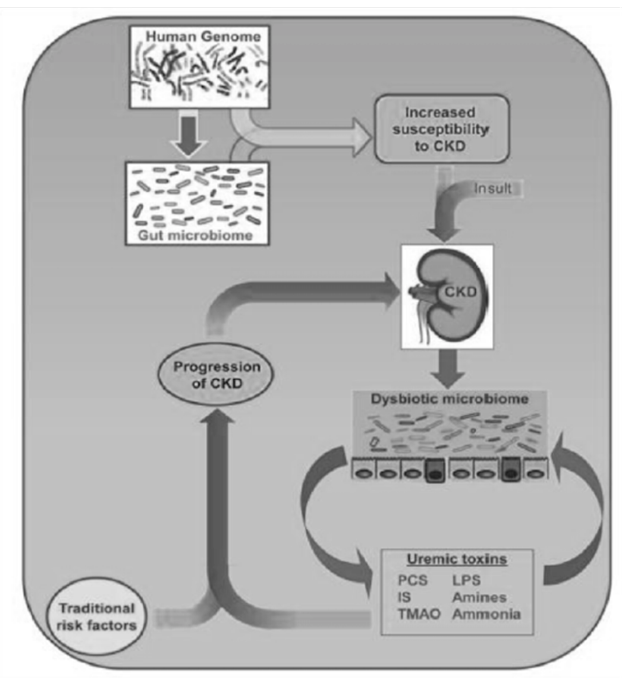
Figure 2. Ramenzani et al.: Role of the gut microbiome in uremia: a potential therapeutic target— AJKD, 2016.